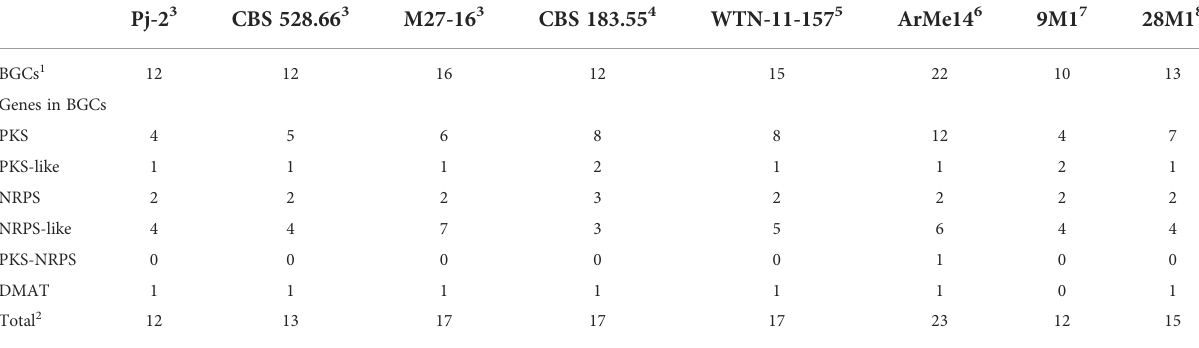
TABLE 2 Biosynthetic gene clusters (BGCs) and secondary metabolite backbone-forming enzymes within BCGs in Didymella